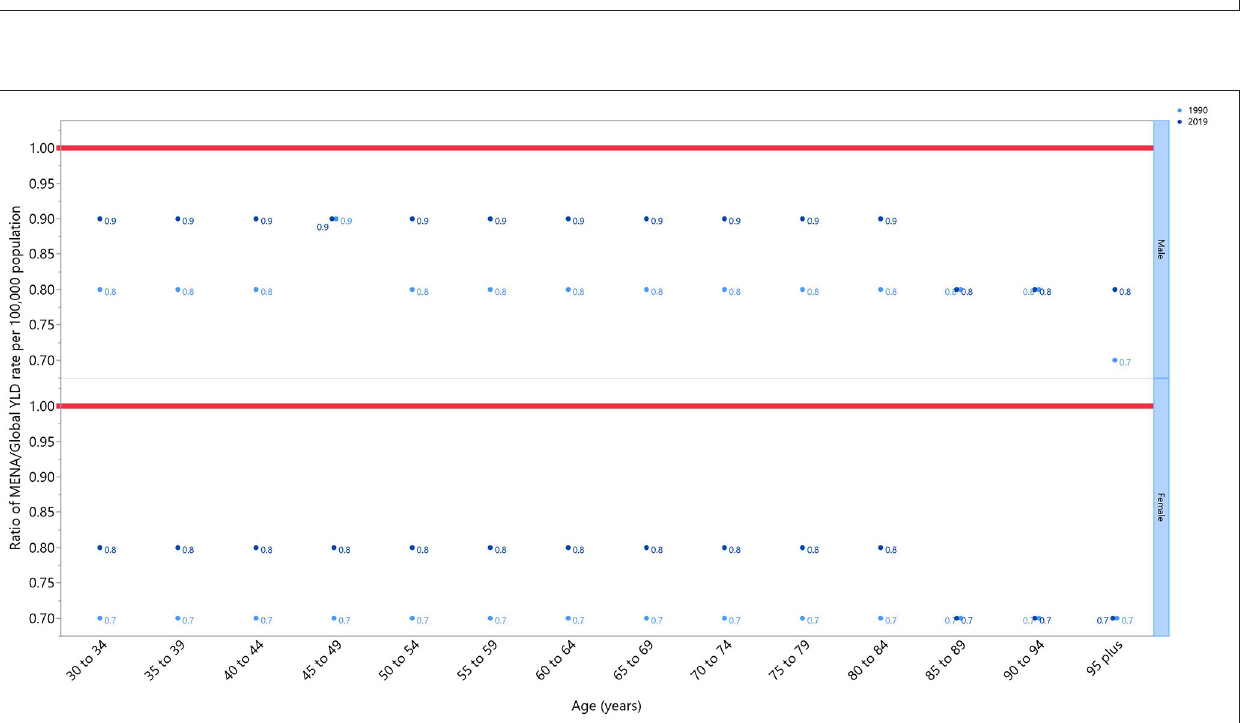
FIGURE 2 | Ratio of the Middle East and North Africa region to the global osteoarthritis YLD rate according to age group and sex, 1990–2019. YLD, years lived with disability (generated from data available from http://ghdx.healthdata.org/gbd-results-tool).